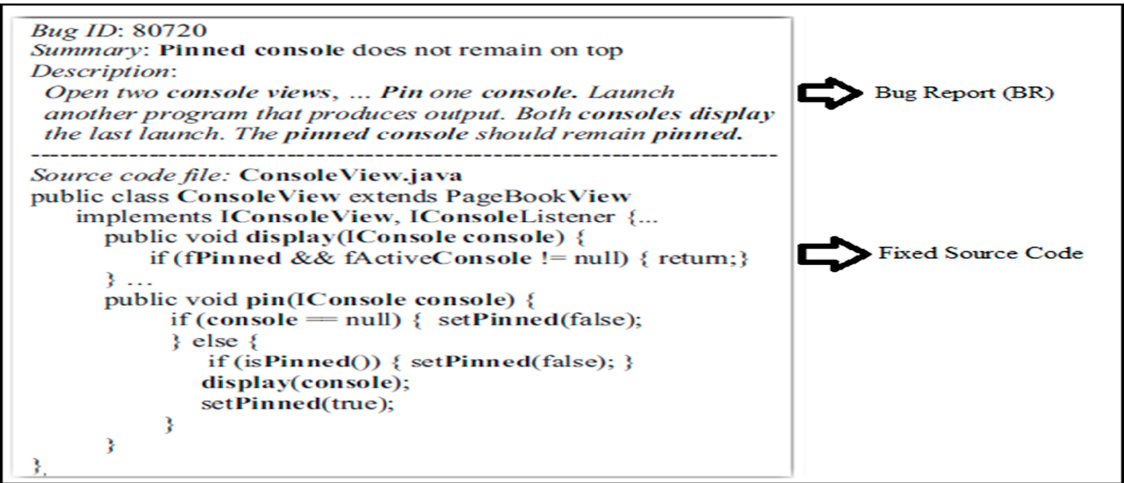
Figure 1. Bug report example.